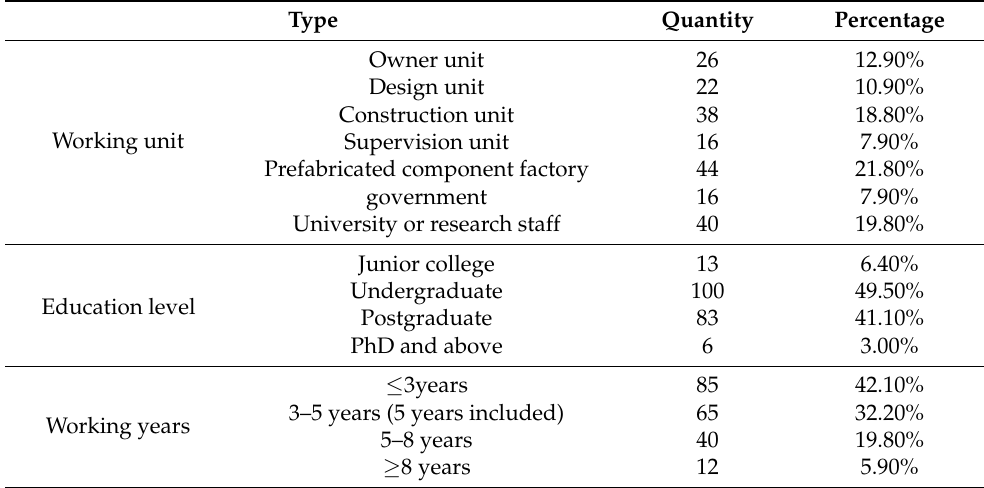
Table 2. Basic information of the